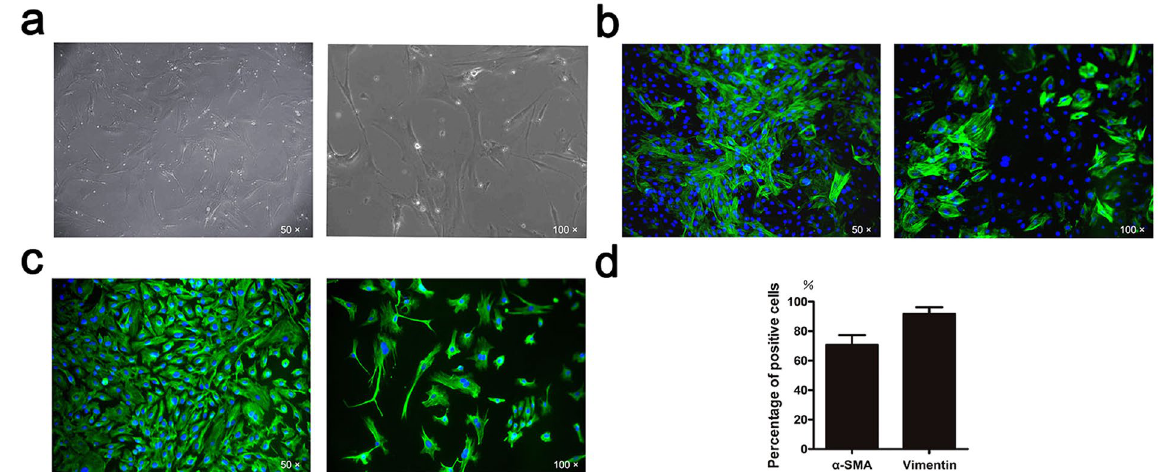
Figure 1. Characteristics and phenotypes of VICs. ( a ) The morphology of VICs (Left: low magnification; Right: high magnification). ( b ) Immunohistochemical staining of α -SMA (Left: low magnification; Right: high magnification). ( c ) Immunohistochemical staining of Vimentin (Left: low magnification; Right: high magnification). ( d ) Quantification of positive staining of α -SMA and Vimentin.